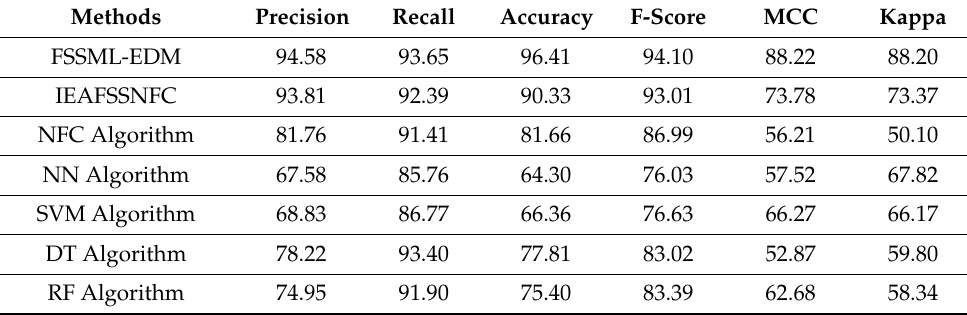
Table 3. Comparative analysis of FSSML-EDM approach with existing methods